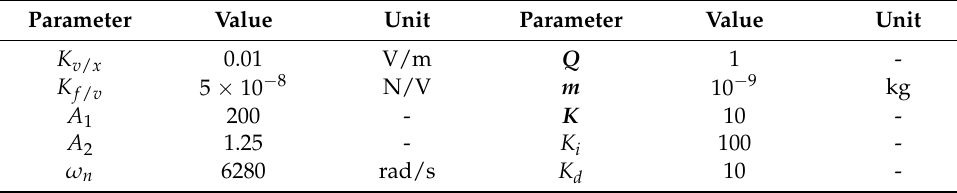
Table 5. Parameters of simulation of